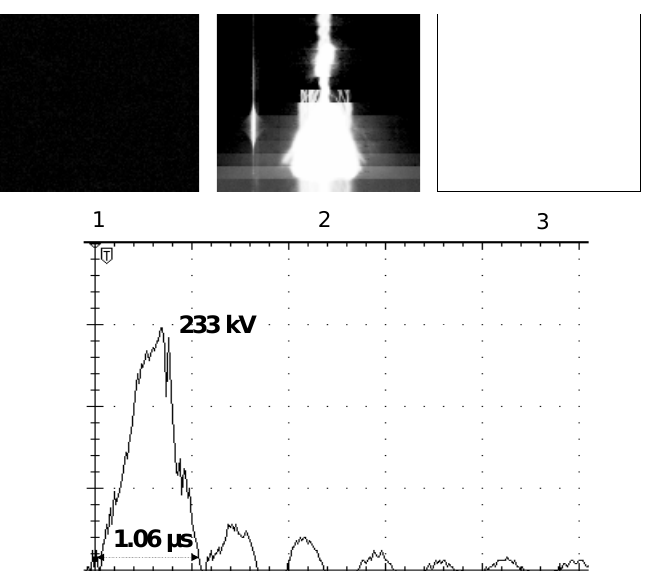
Figure 3. Images of 1% toluene in cyclohexane, positive polarity (233 kV peak applied, 70 mm gap). Frame rate of 430,000 FPS, 2.32 µs between frames, and 1.75 µs exposure time. The TTB from the waveform is <1.06 µs. The annotations “1 to 3” above refer to the frame number.